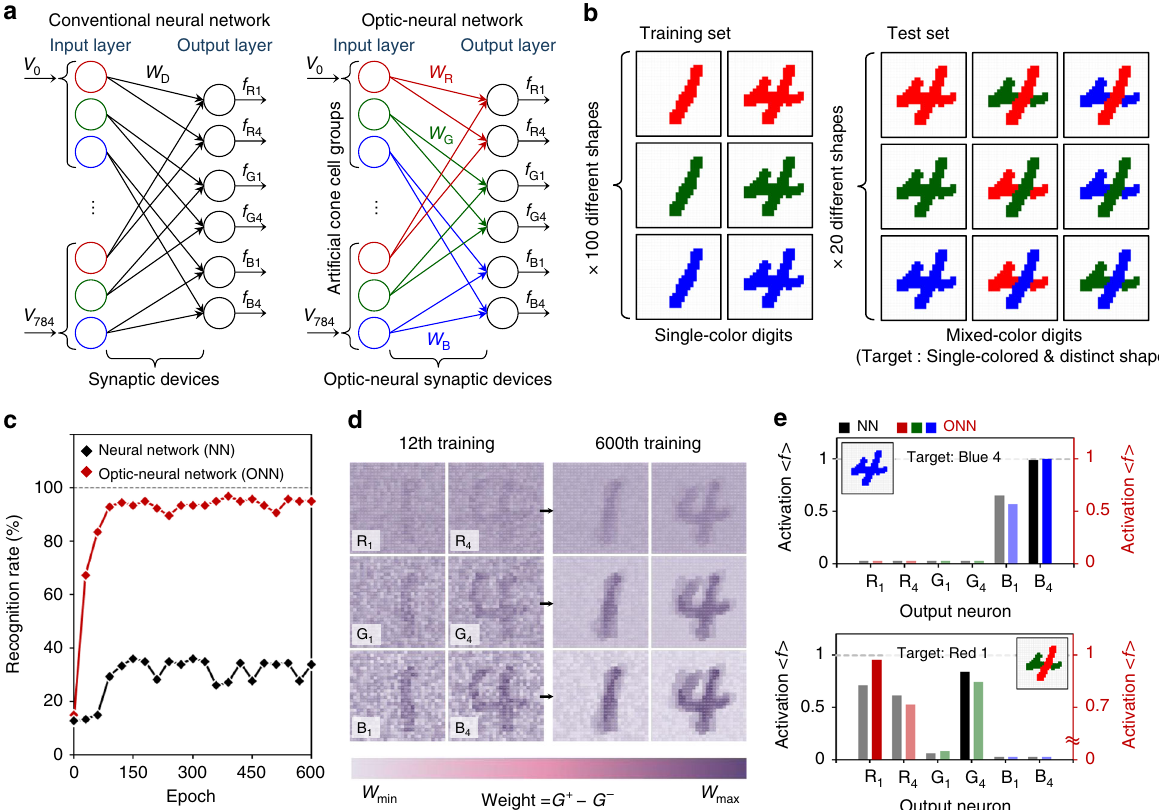
Fig. 4 Colored and color-mixed pattern recognition based on an arti fi cial optic-neural network. a Developed ONN for recognition of 28 × 28 RGB-colored images. b Examples of the training and the testing datasets consisting of single-colored and color-mixed numeric pattern images, respectively. c Recognition rate as a function of number of training epochs. d Weight mapping images after the 12th and 600th training epoch. e Activation values of each output neuron in cases of a single-colored number (blue 4) and a color-mixed number (red/green-mixed 4) after the 600th training